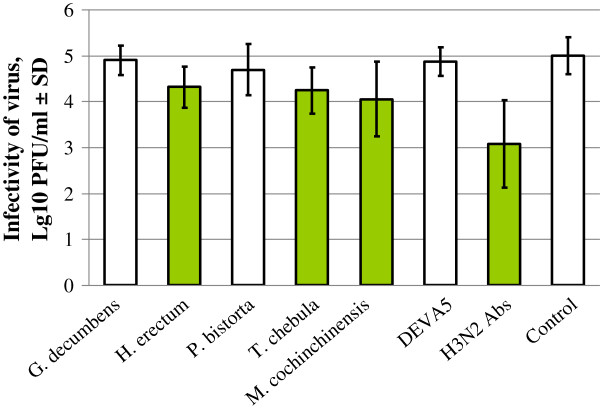
Titres of infectious virus in samples containing ~1 × 105 PFU A/Teal/Tunka/7/2010 (H3N8) treated with 1% plant extracts. Control – water-treated virus; H3N2 Abs - A/Teal/Tunka/7/2010 (H3N8) treated with 1:100 diluted specific antibodies to the H3N2 influenza virus. Green blocks designate the samples that showed a significant reduction in viral titres in comparison to the control by Student’s t-test (p ≤ 0.05). Error bars reflect standard deviations.